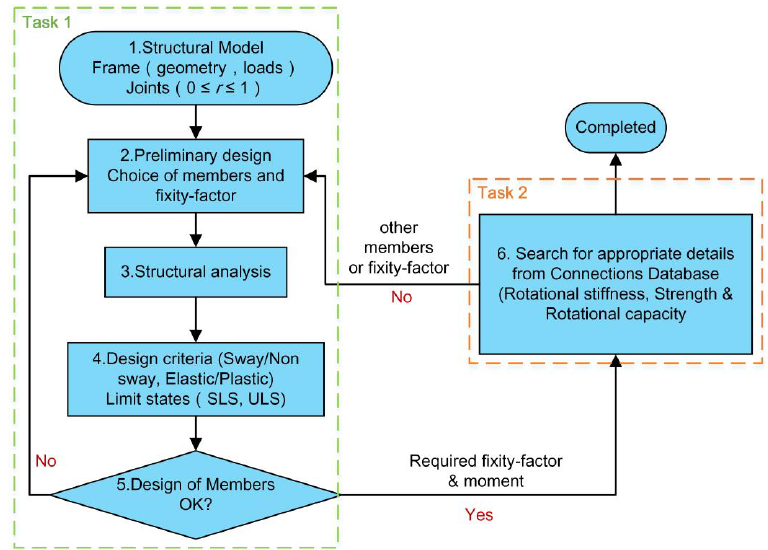
Figure 2. Design semi-rigid steel frame via the query of connection database.